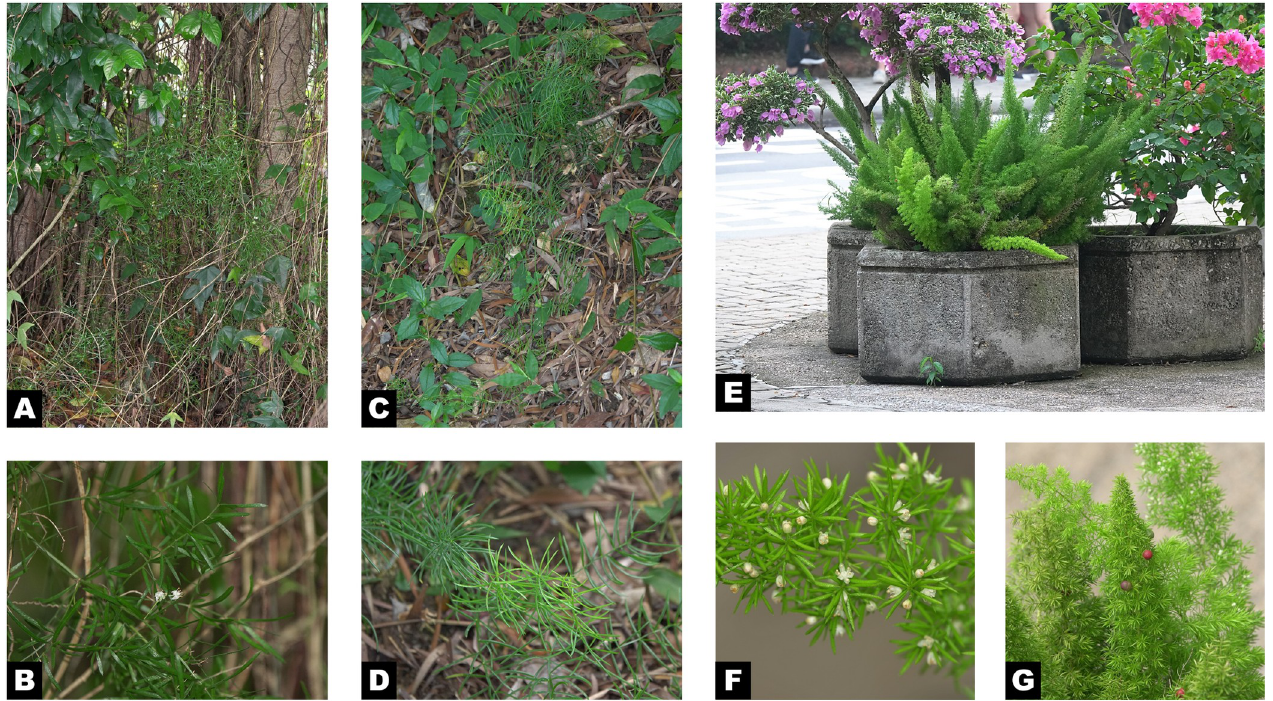
Fig 1. Photos of three Asparagus plants collected at the Chinese University of Hong Kong. A,B: A . aethiopicus . A. Plant climbing under Ficus microcarpa L. f. and twining with Passiflora suberosa L. B. Flowers and cladodes. C,D: A . cochinchinensis . C. Plant straggling on ground. D. Cladodes. E,F,G: A . densiflorus ‘Myers’. E. Plant growing in a concrete pot. F. Flowers and cladodes. G. Fruits and branch apices.